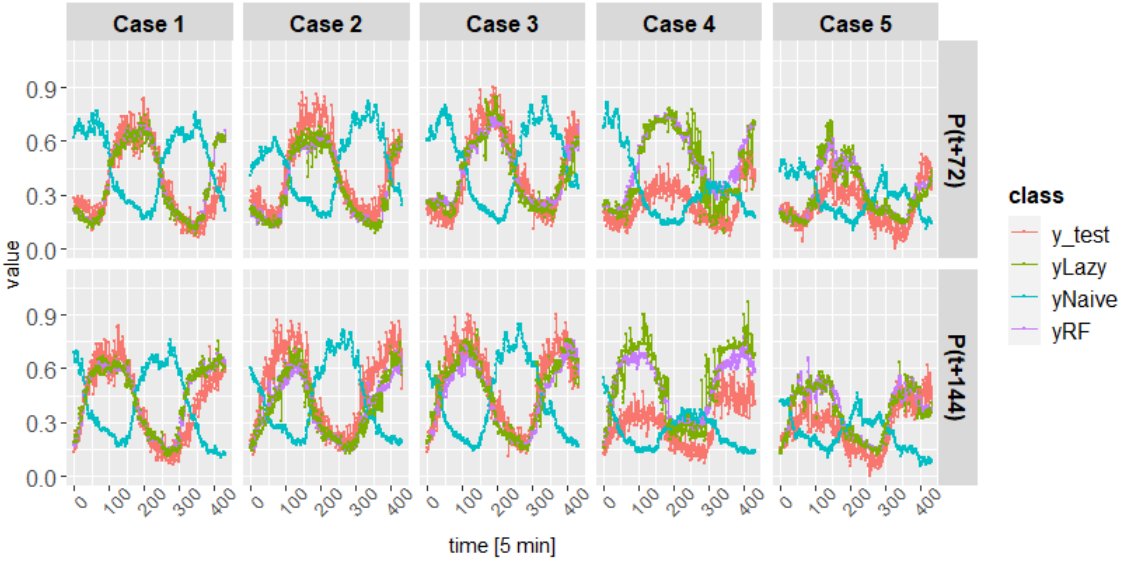
Figure 6. Visualization of actual ( ytest ) and predicted load trajectories for a 12 h forecasting